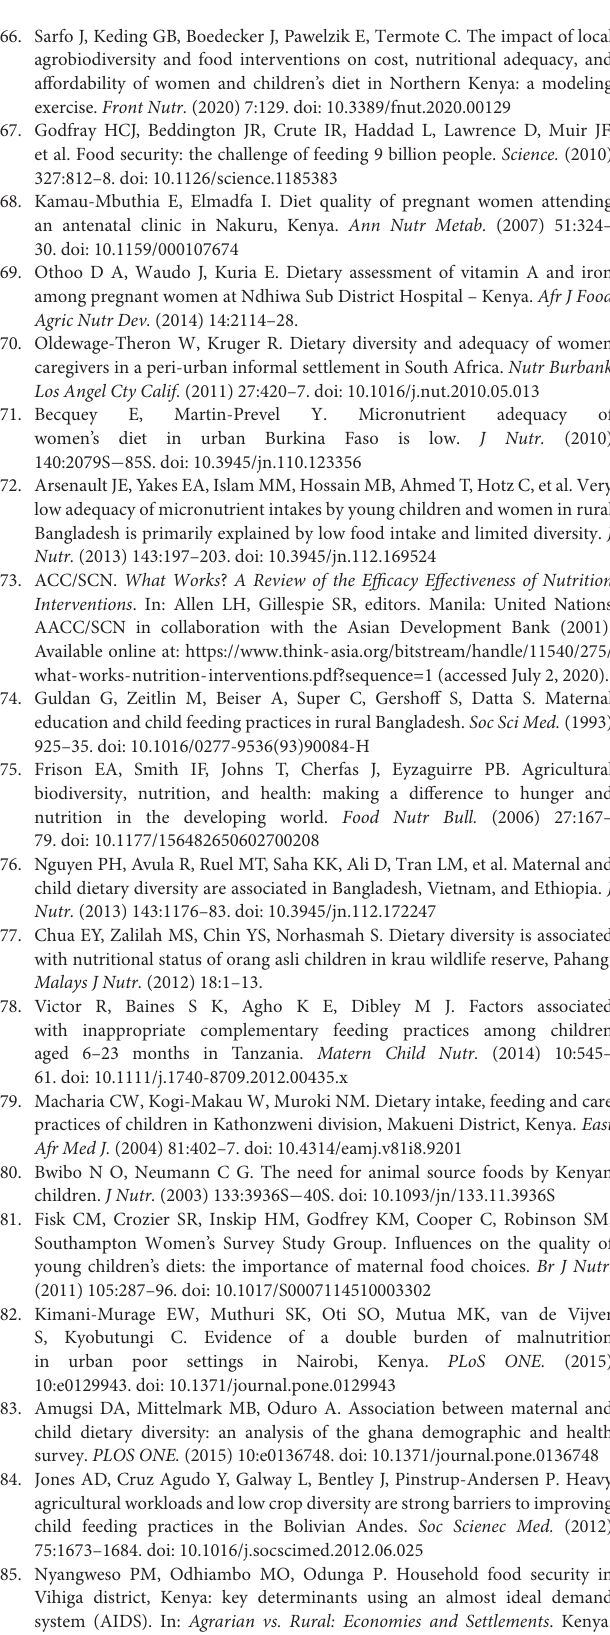
Frontiers in Nutrition |